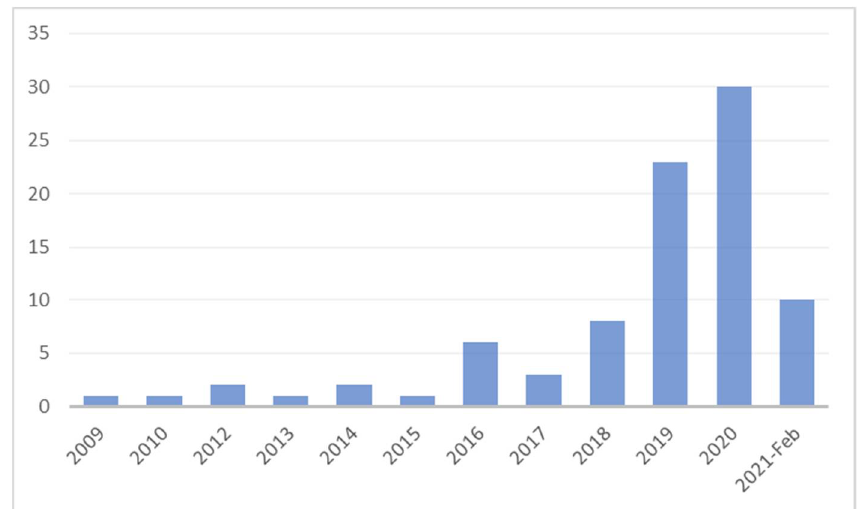
Figure 2. Publications by year (selected studies).